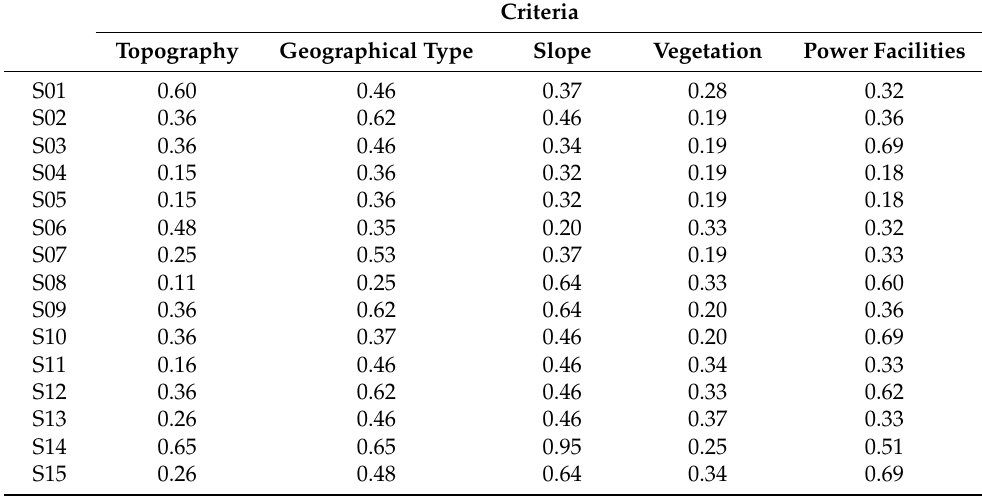
Table 14. Crisp decision matrix.